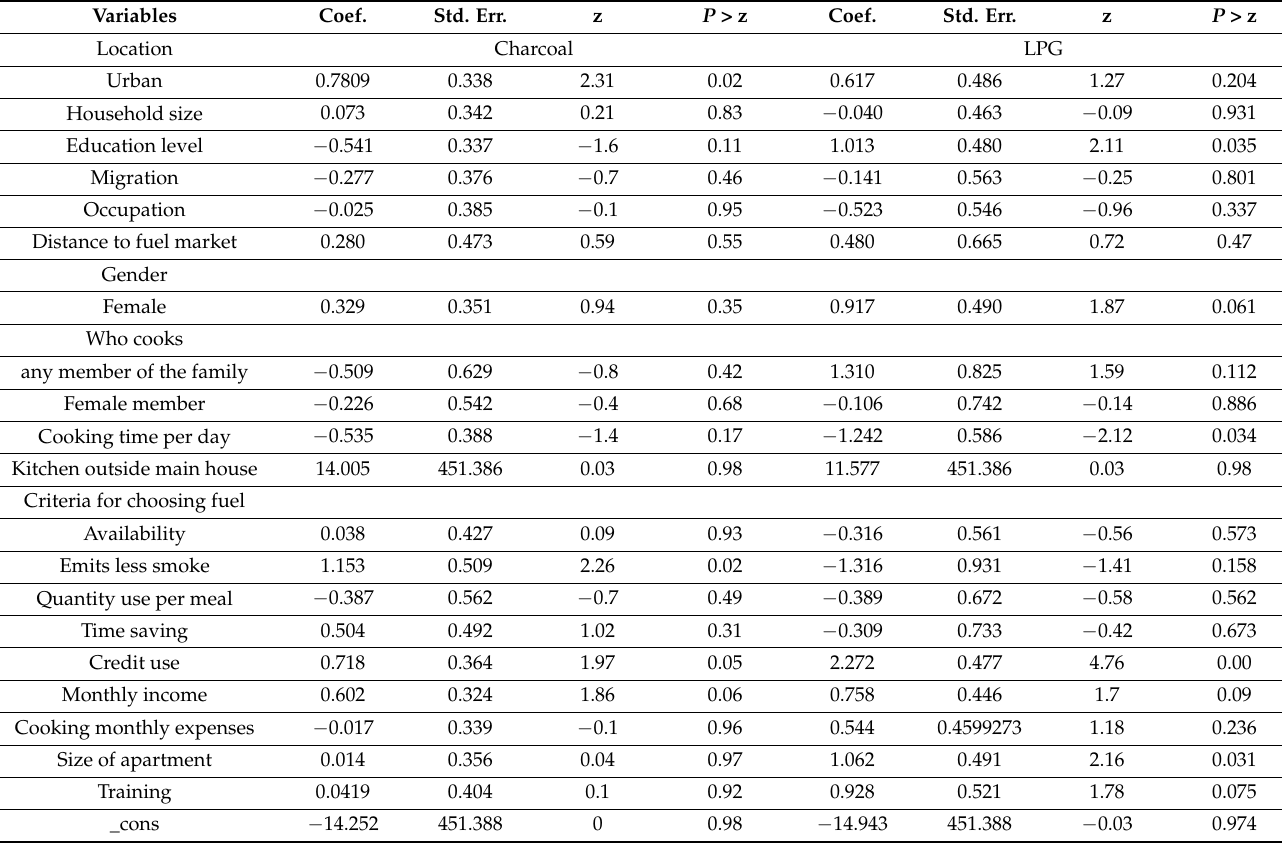
Table 4. Multinomial logit analysis for charcoal and liquefied petroleum gas (LPG) as compared to firewood.